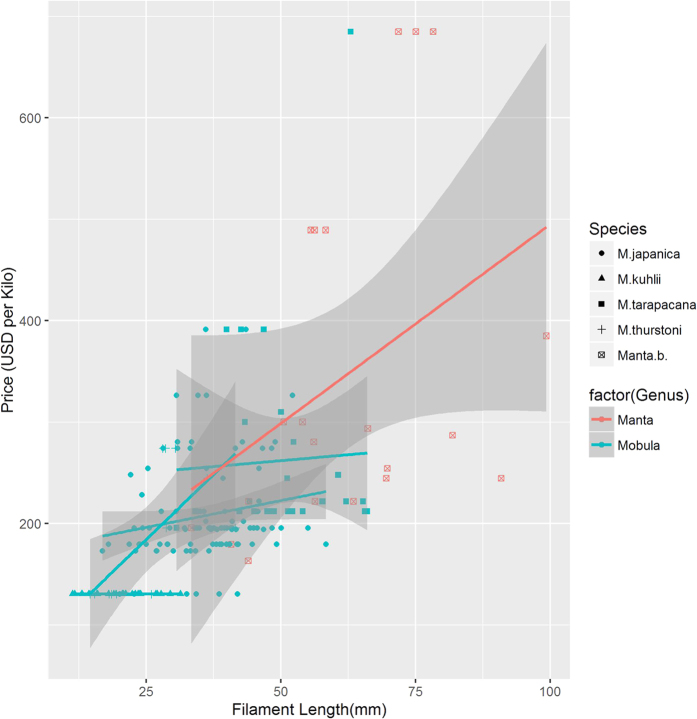
Price trends for dried gill rakers in South China markets, according to size.